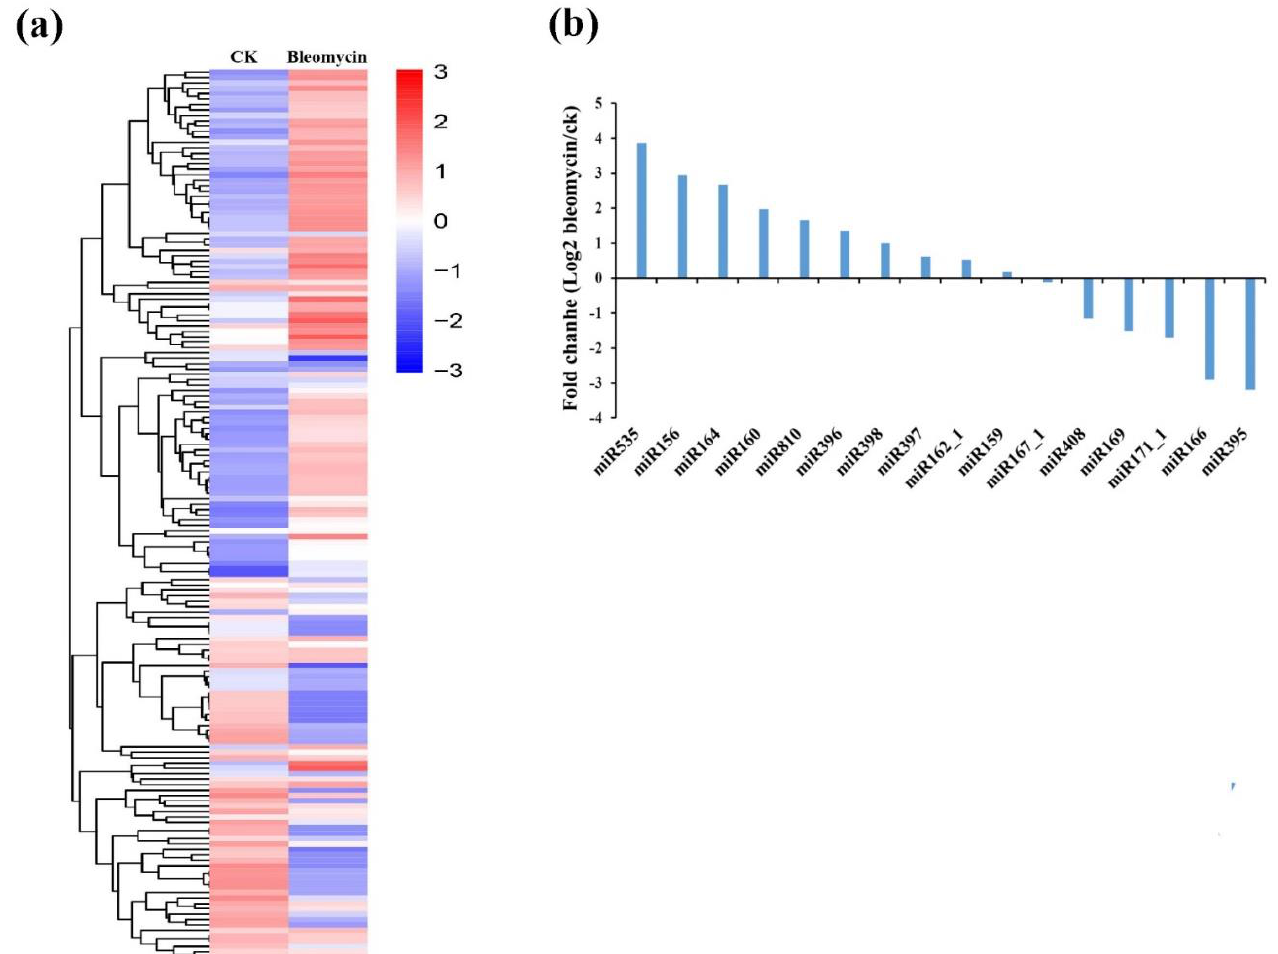
Figure 5. The differentially expressed miRNAs and conserved miRNA families in the two libraries. ( a ) Hierarchical cluster and expression profile analyses of the differentially expressed miRNAs between the CK (control) and bleomycin treatment libraries (Bleomycin). Each column represents a sample, and each row represents a single miRNA. The data in the heatmap are the log10 values of transcripts per million (TPM). The bar indicates the expression scale for miRNAs; Red represents highly expressed miRNAs and grey represents non-expressed miRNAs; ( b ) A comparison of the relative expression of differentially expressed conserved miRNA families. The ordinate is the difference multiple of each differentially expressed miRNA (log 2 Bleomycin/CK). The abscissa represents differentially expressed conserved miRNA families.